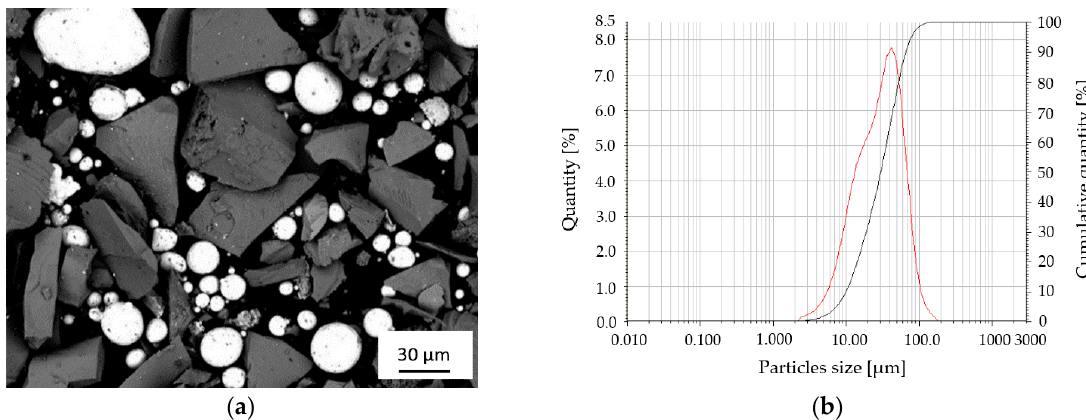
Figure 2. Scanning electron microscope—SEM (back-scattered electrons—BSE) micrograph of O-Cu/SiC powder (a mixture of spherical Cu powder and SiC powder) ( a ) and size analysis of the mixed powders ( b ).